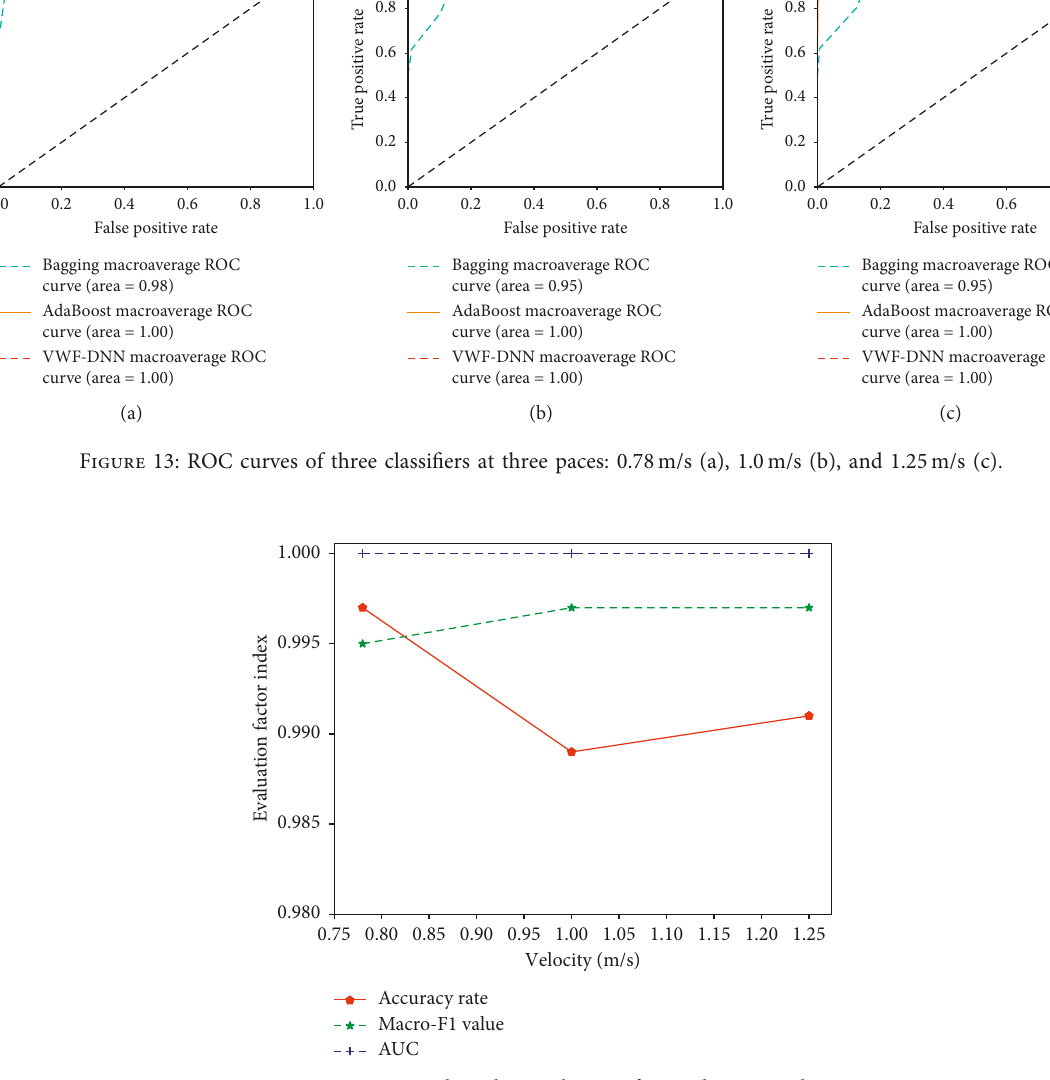
Figure 14: VWI-DNN algorithm evaluation factor changes with